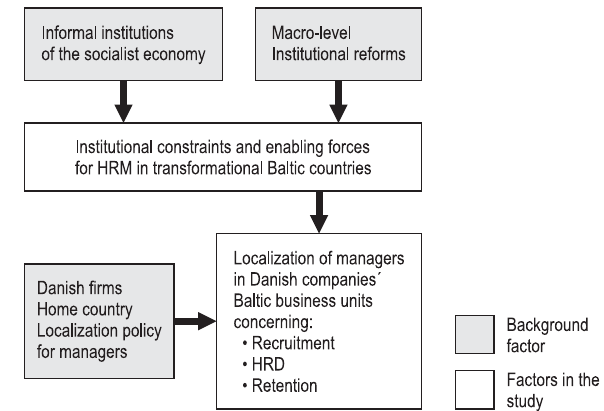
Fig. 1. Conceptual model of the